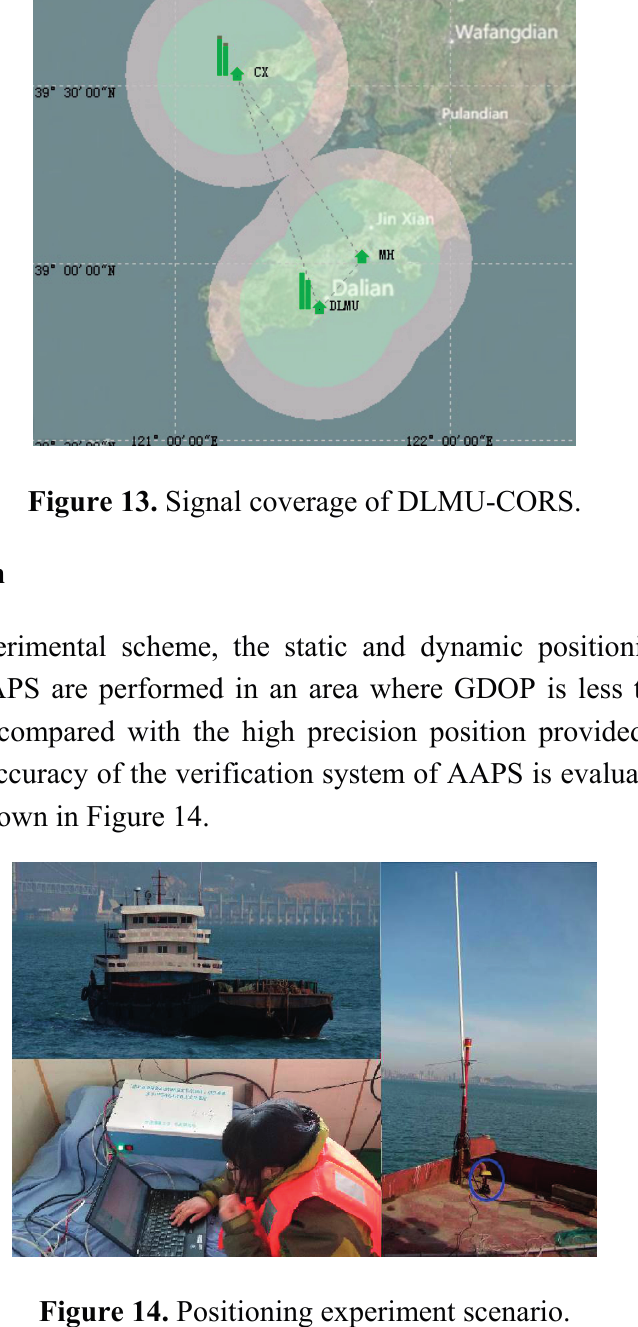
Figure 14. Positioning experiment